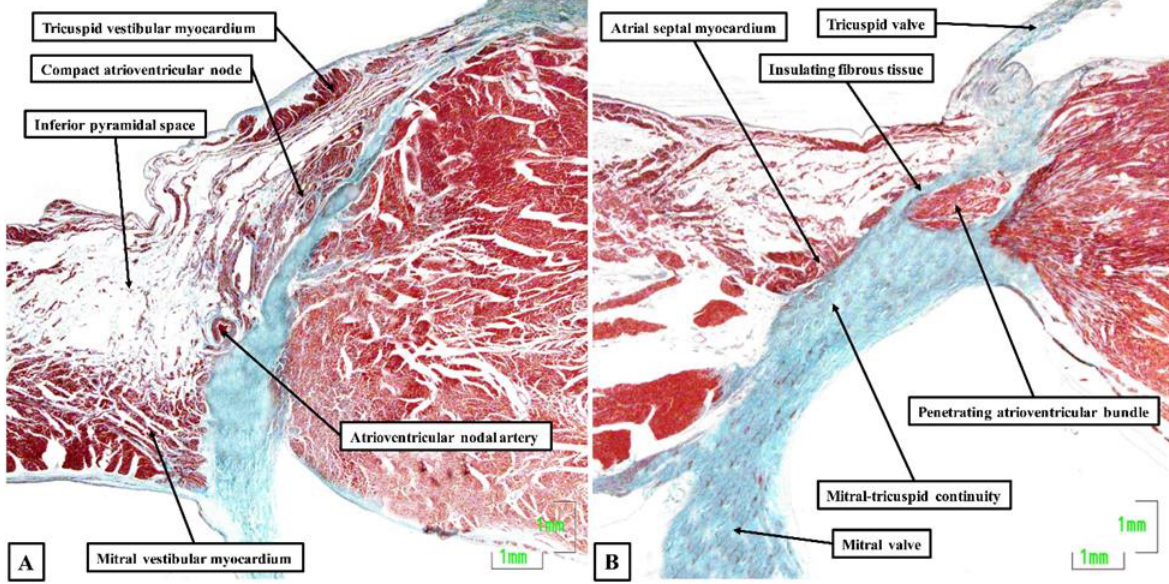
Figure 1. Atrioventricular node and penetrating bundle: The histological sections, stained using the trichrome technique, show the features of the atrioventricular node ( A ) and the insulation provided to produce the penetrating atrioventricular bundle ( B ). The sections were made using an adult human heart.